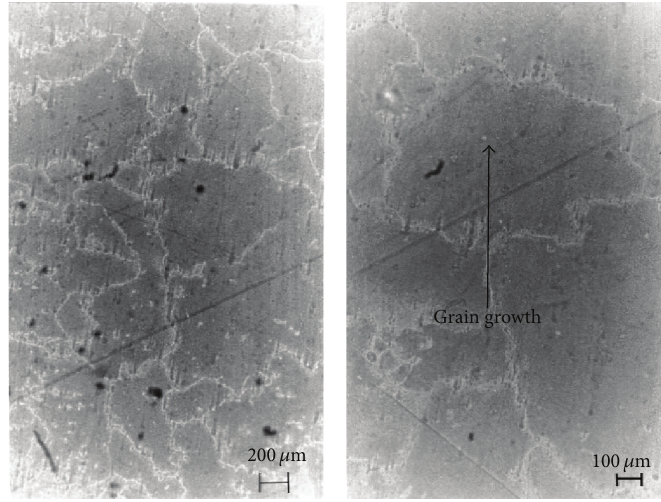
Figure 6: Grain growth in the high temperature (zone D).